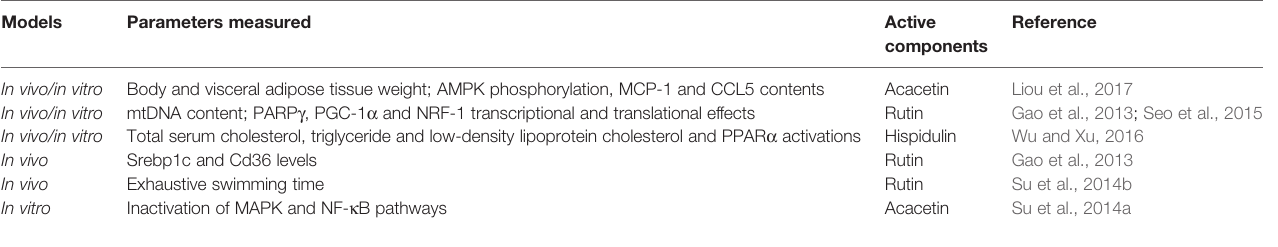
TABLE 3 | Summary of adipogenesis suppression effects of “ Snow lotus ” and/or its major biochemical.